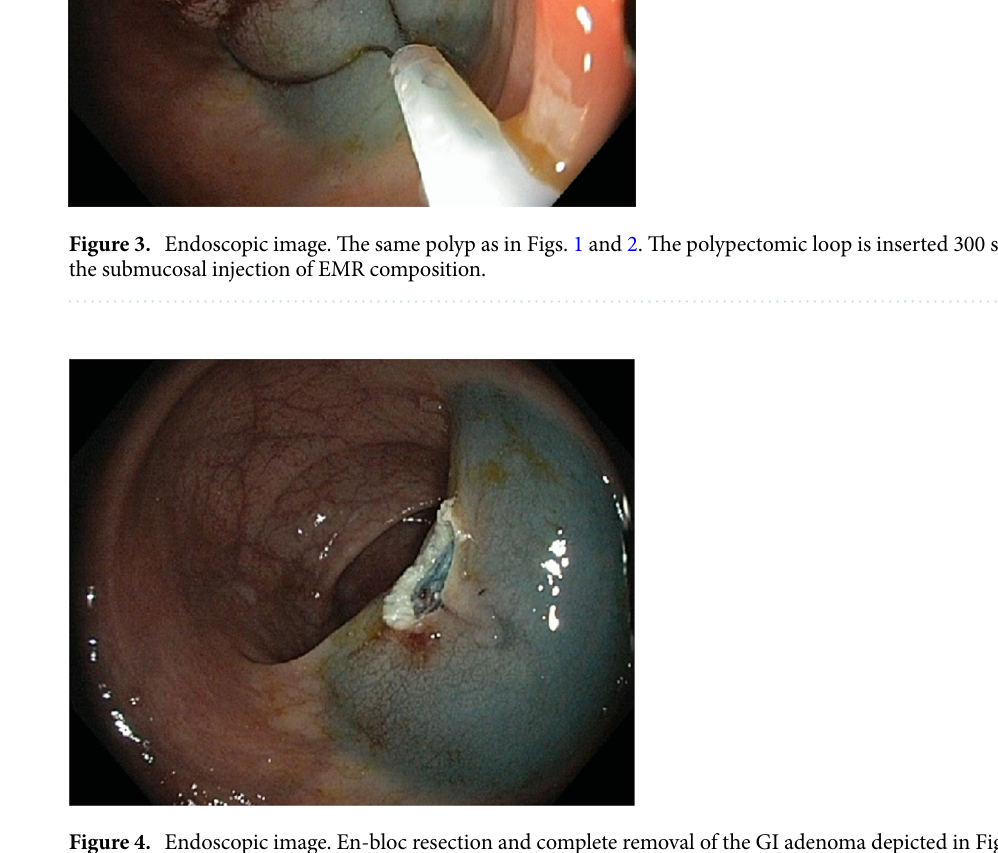
Figure 4. Endoscopic image. En-bloc resection and complete removal of the GI adenoma depicted in Figs. 1, 2 and 3. 330 s after the submucosal